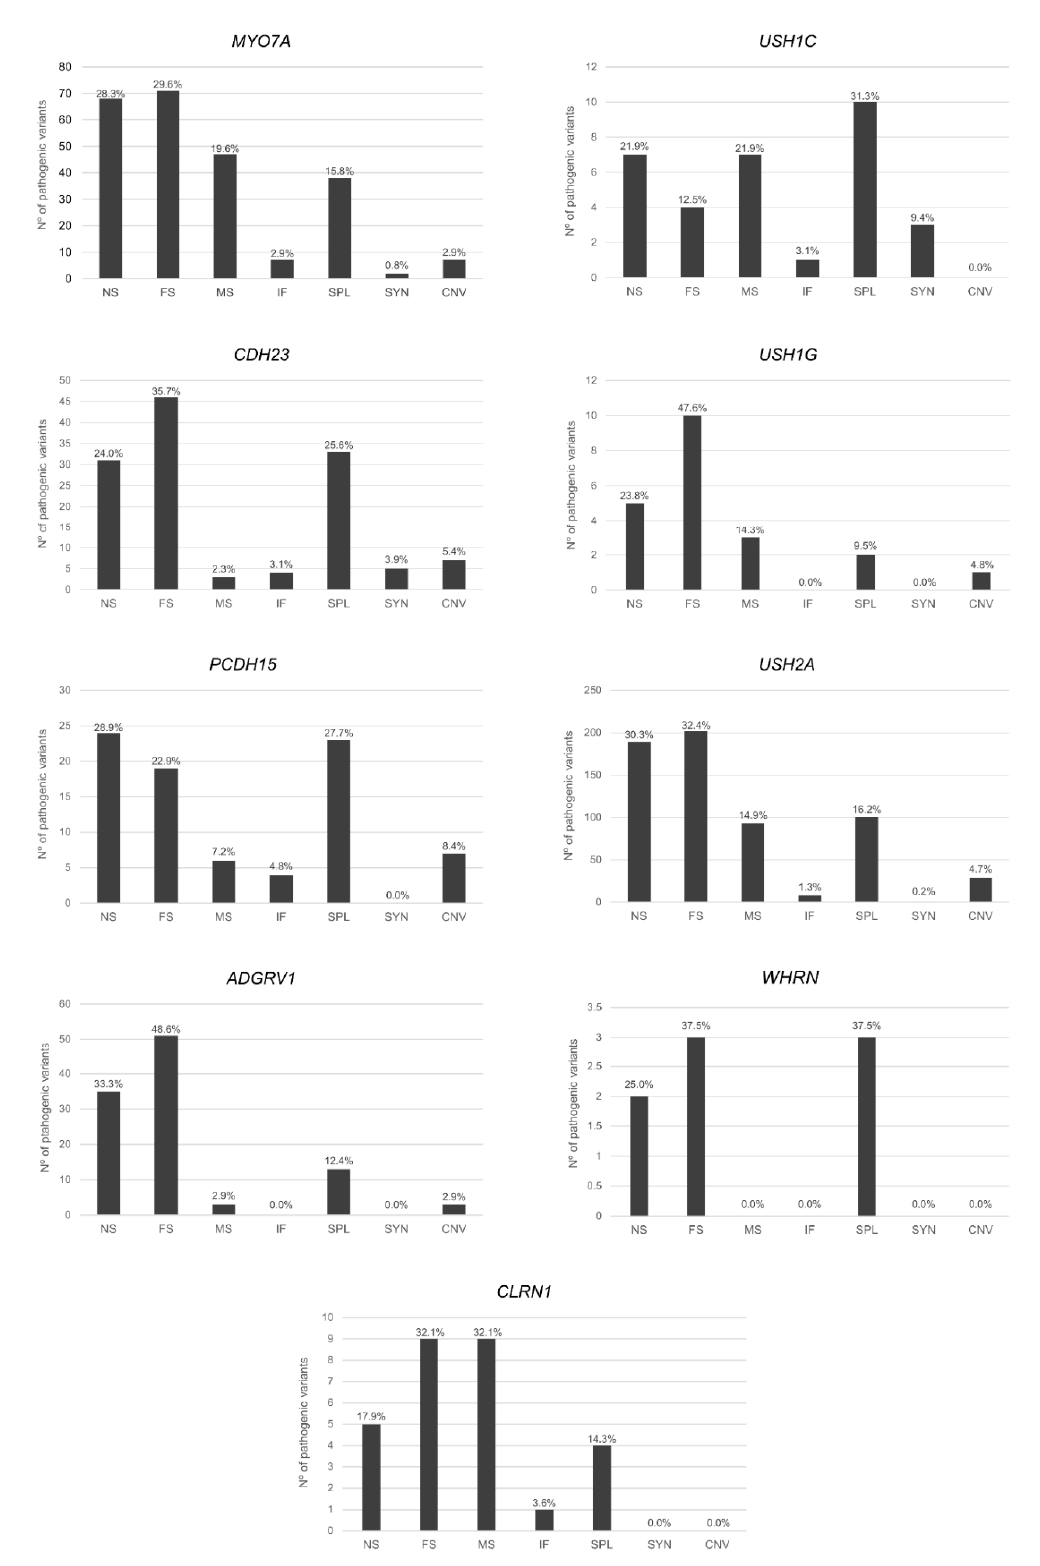
Figure 2. Mutation count in USH genes ( MYO7A , USH1C , CDH23 , PCDH15 , USH2A , ADGRV1) . Abbreviations: NS, nonsense variant; FS, frameshift variant; MS, missense variant; IF, in-frame indel variant; SYN, synonymous; SPL, splicing variant.